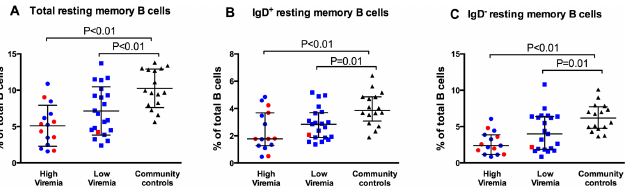
Fig 3. HIV-infected children have reduced proportions of resting memory B cells. Proportions of (A) total resting memory B cells, (B) IgD + resting memory B cells and (C) IgD - resting memory B cells as percentages of total B cells. Each symbol representsa child. High viremia, (cid:21) 5000 RNA copies/ml; Low viremia, < 5000RNA copies/ml. Horizontallines and error bars represent median, 25 th and 75 th percentiles. Red symbols represent HIV-infectedchildrenwho were not on HAART. Blue symbols represent HAART- treated children. Statistical test: Wilcoxon’srank sum test.